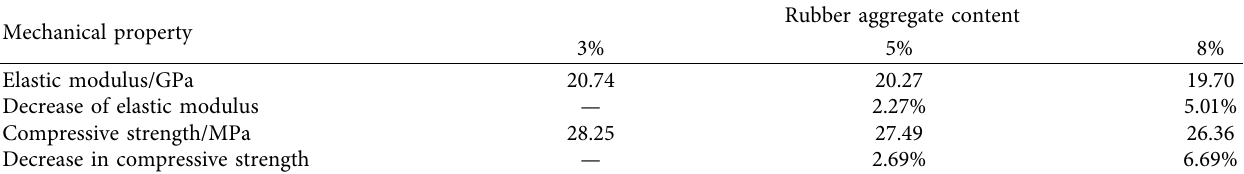
concrete with rubber particle size of 2.5 mm are 20.08 GPa